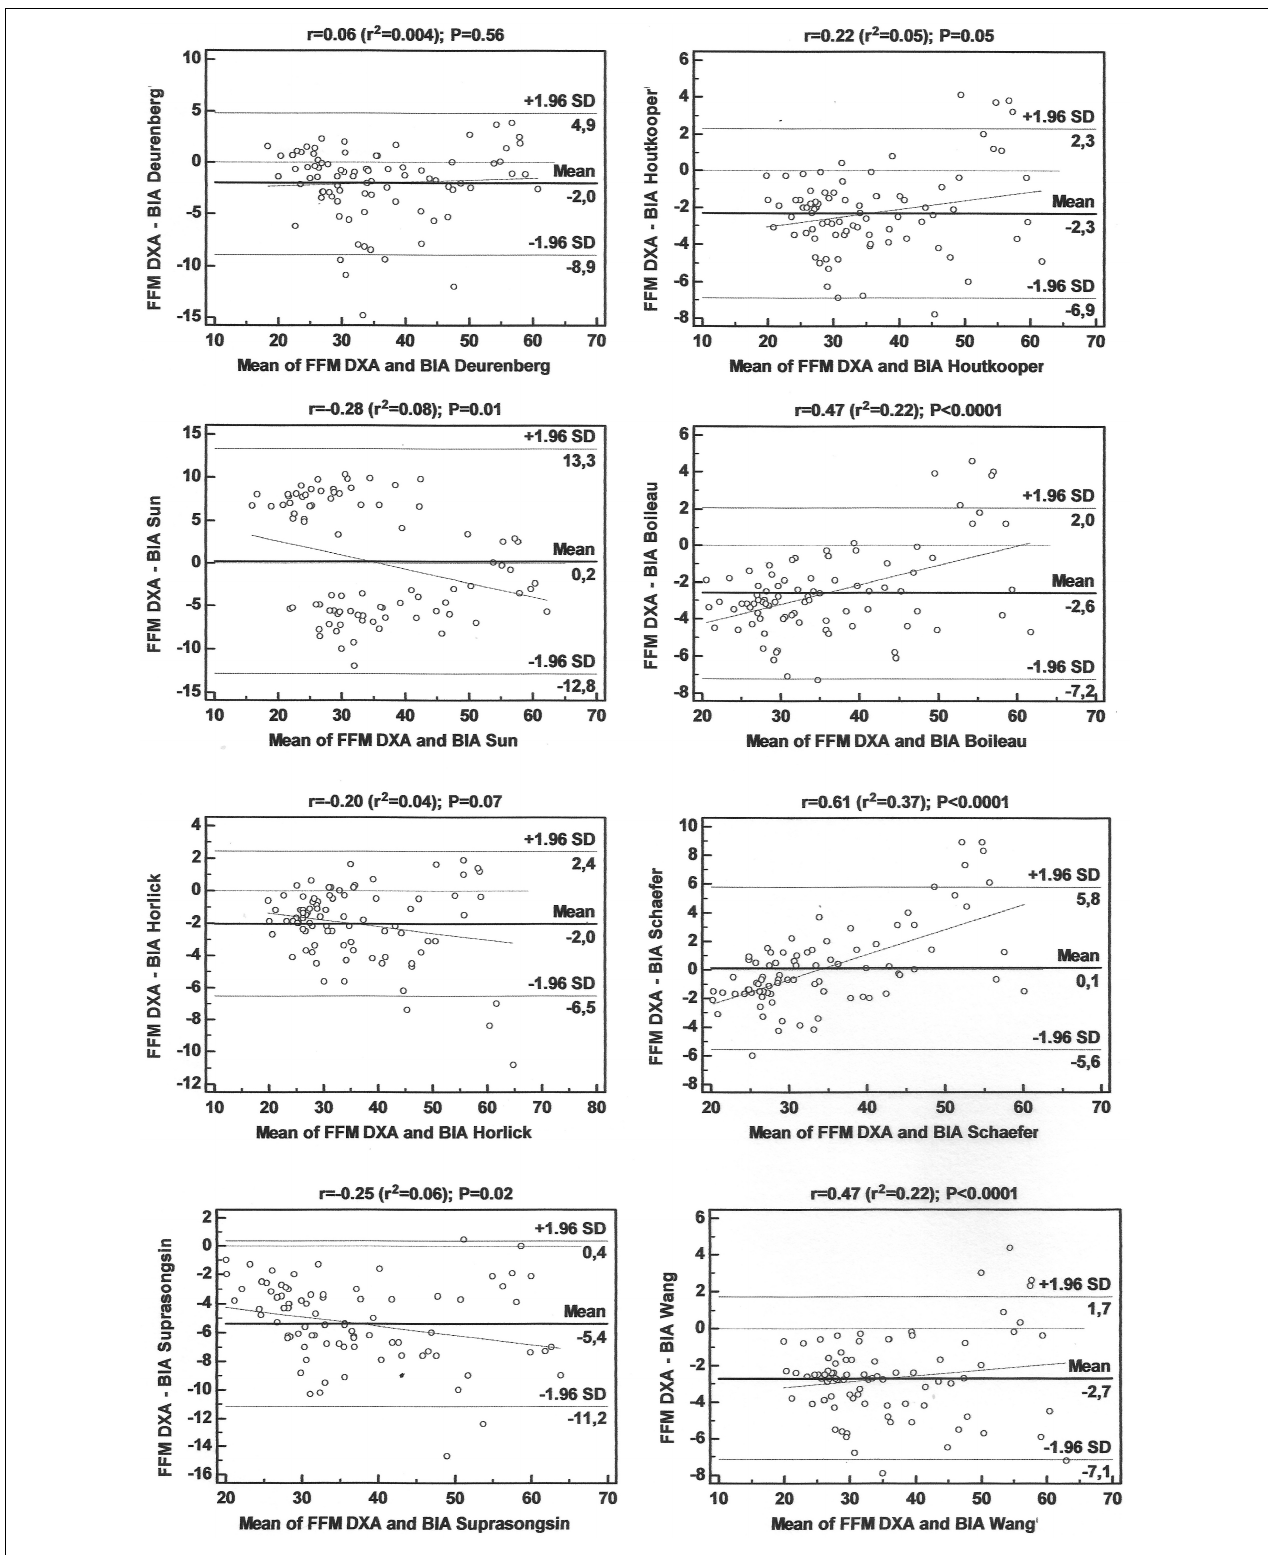
FIGURE 2 | Bland-Altman plots for the concordance limits between values determined by the reference method (DXA) and eight equations for fat-free mass (FFM) in adolescents.